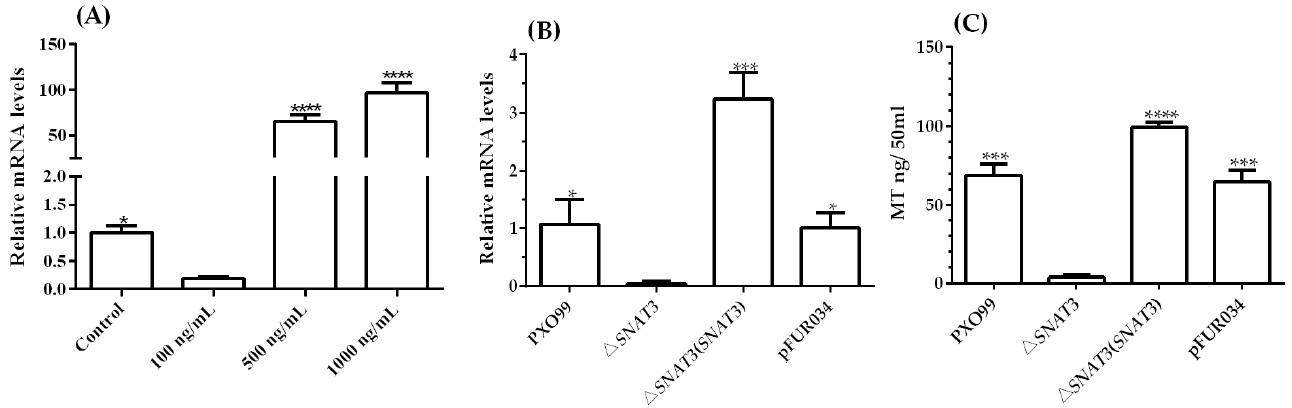
Figure 6. Expression of xoSNAT3 in Xoo and under MT treatment. ( A ) The expression of xoSNAT3 under MT treatment (100, 500 and 1000 ng/mL). ( B ) The expression of xoSNAT3 in Xoo , △ xoSNAT3 mutant and complemented strain. ( C ) Concentration of MT in Xoo , △ xoSNAT3 mutant and comple ‐ mented strain. The control experiment was carried out using Xoo strain PXO99 without MT treatment. PXO99 refers to the wild ‐ type strain. pFUR034 refers to Xoo strain carrying mentioned blank plasmid as a mock control. Asterisks indicate statistically significant differences determined using Student’s t ‐ test (* p < 0.05; *** p < 0.001; **** p < 0.0001).